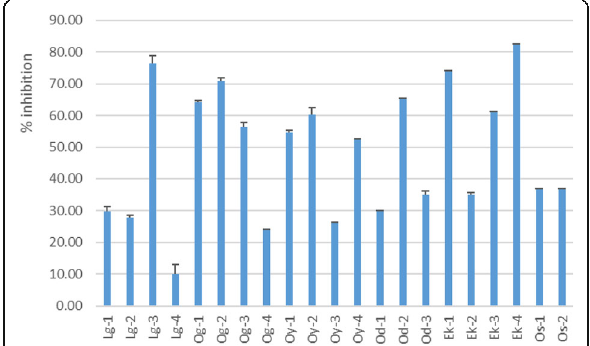
Fig. 3 Saponin content of Moringa oleifera leaf from the 21 locations. The results are mean of triplicates with the error bars (standard deviation). The chart shows significant between- and within-group differences in the saponin content of the samples from the locations